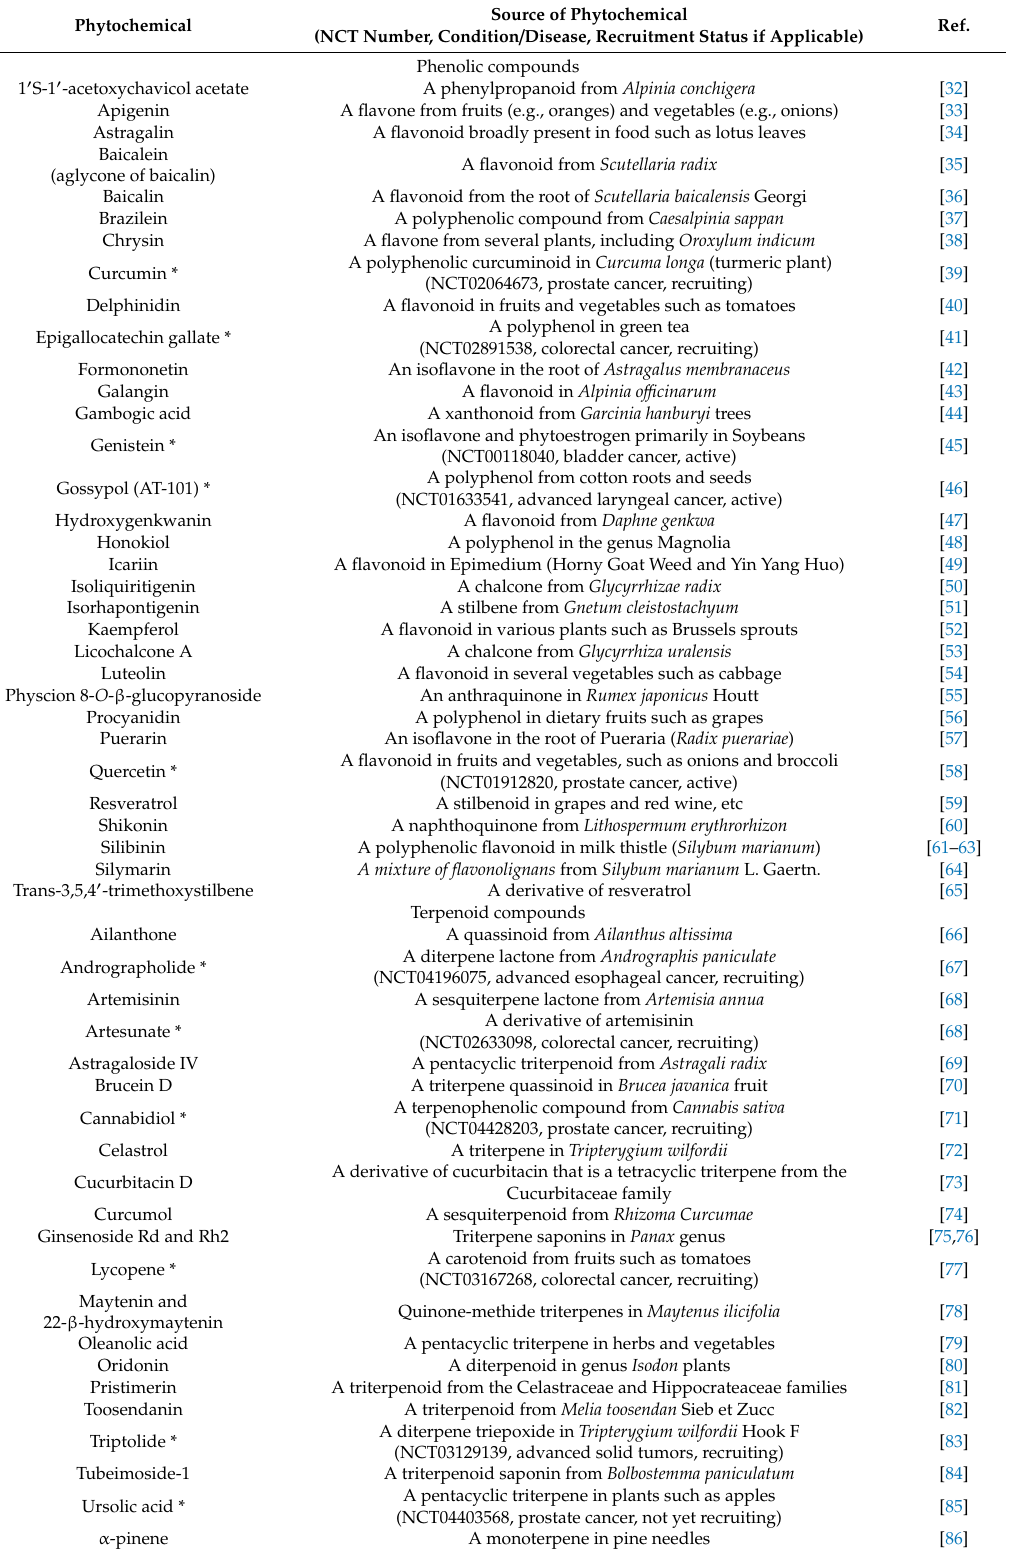
* indicates phytochemical compounds currently in clinical trials on cancer. The national clinical trial (NCT) number, condition / disease, and recruitment status registered in ClinicalTrials.gov are